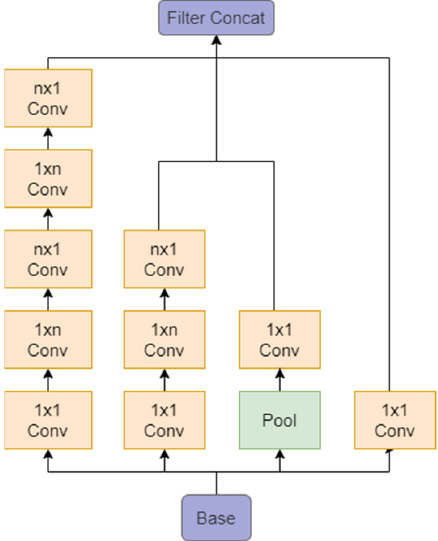
Figure 6. Structure of Inception Modules.